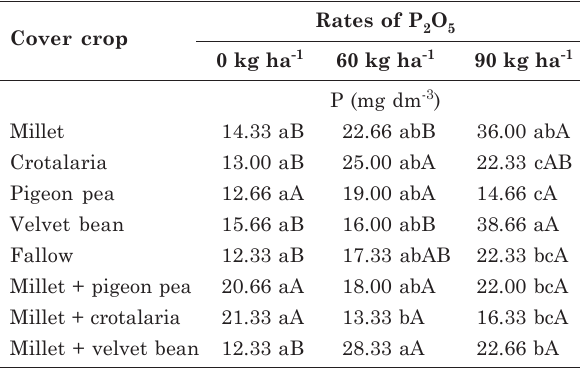
Means followed by the same letter in the column do not differ by Tukey’s test at 5